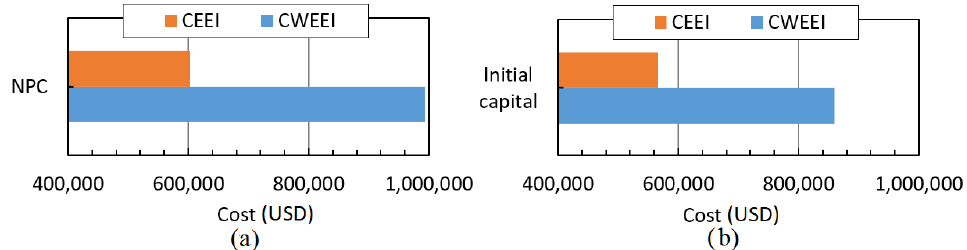
Figure 8. Costs of the CEEI and the CWEEI for SPVS/BESS configuration, ( a ) NPCs and ( b ) Initial